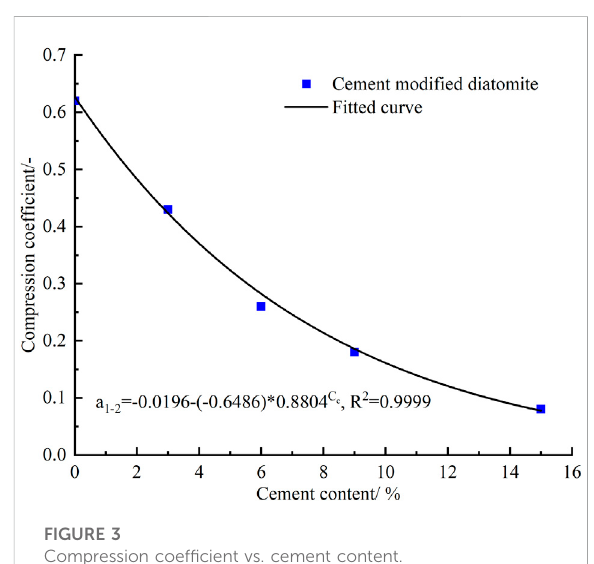
FIGURE 3 Compression coef fi cient vs. cement